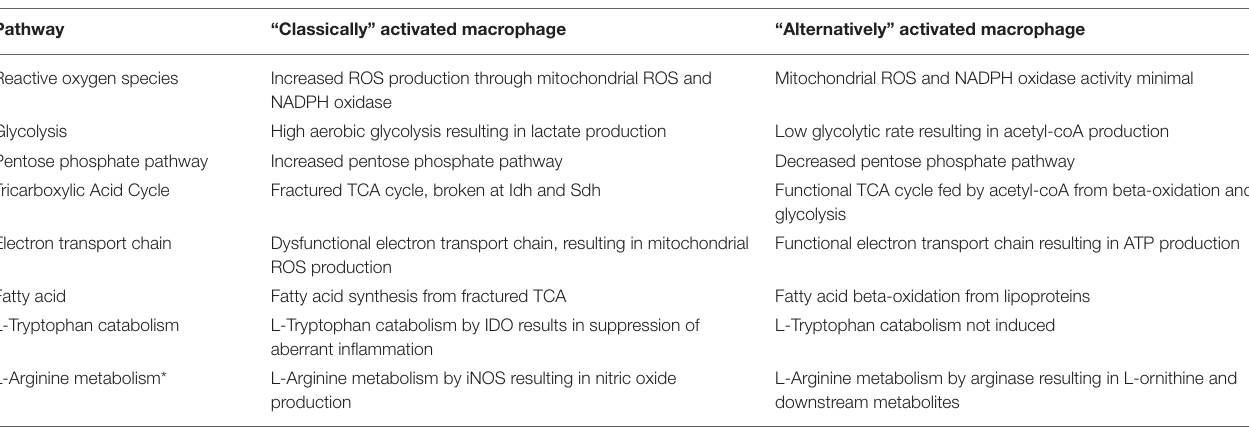
TABLE 1 | Metabolic function in macrophage